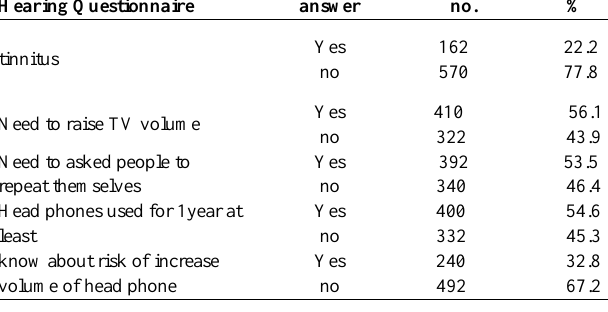
Table 4: percentages of patients taken in the study that suffer from tinnitus, the percentage of exposure to the sounds of television and headphones, and their knowledge of its